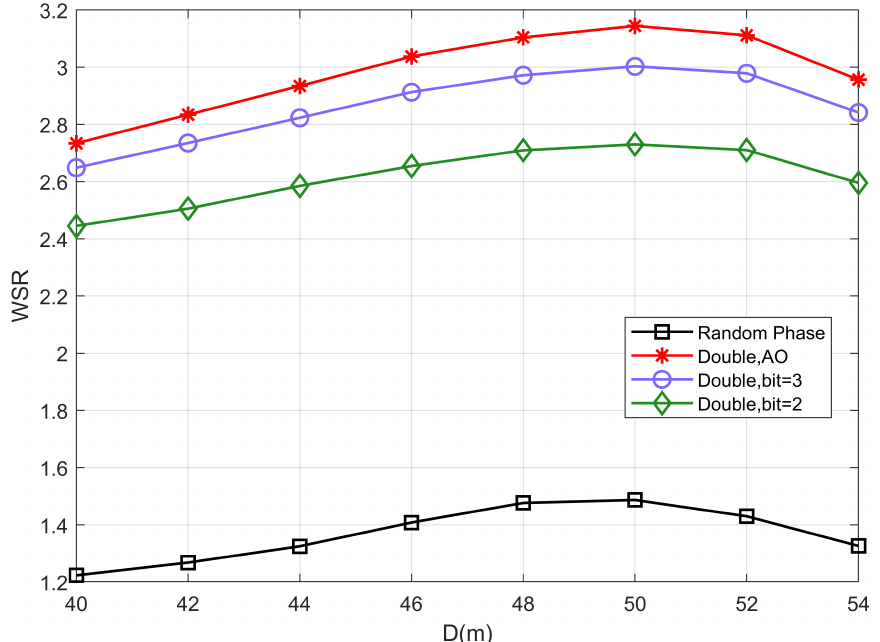
Figure 7. The WSR versus the horizontal coordinate of IRS 2.